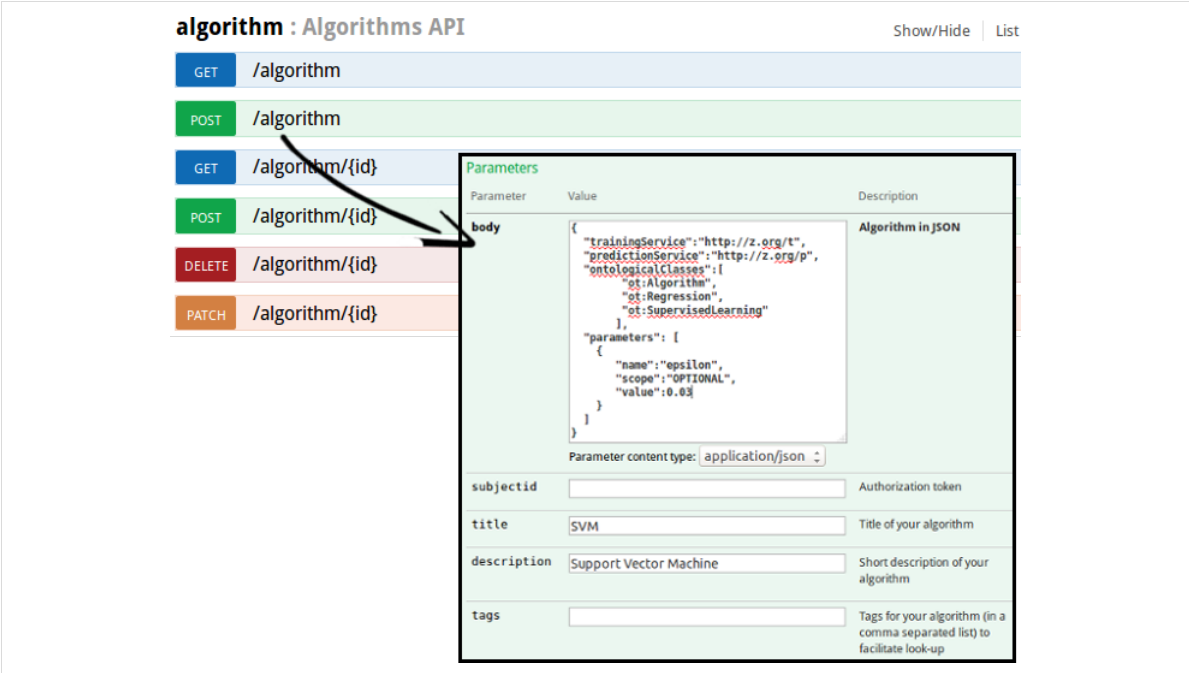
Figure 23: Algorithm API that allows to consume as well as register new algorithms (following the JPDI specification). Clients can use this API to (i) GET a list of all algorithms, (ii) register a new algorithm, (iii) GET the representation of an existing algorithm, (iv) Use an algorithm, (v) Delete an existing algorithm or (vi) use the HTTP method PATCH to modify an algorithm resource.